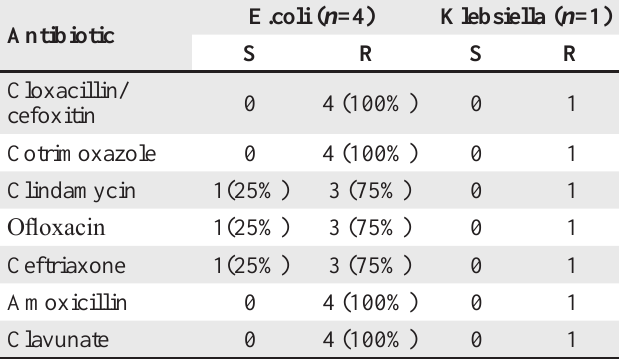
Table 4 : Sensitivity pattern of E. coli and Klebsiella to particular second line antibiotic Antibiotic